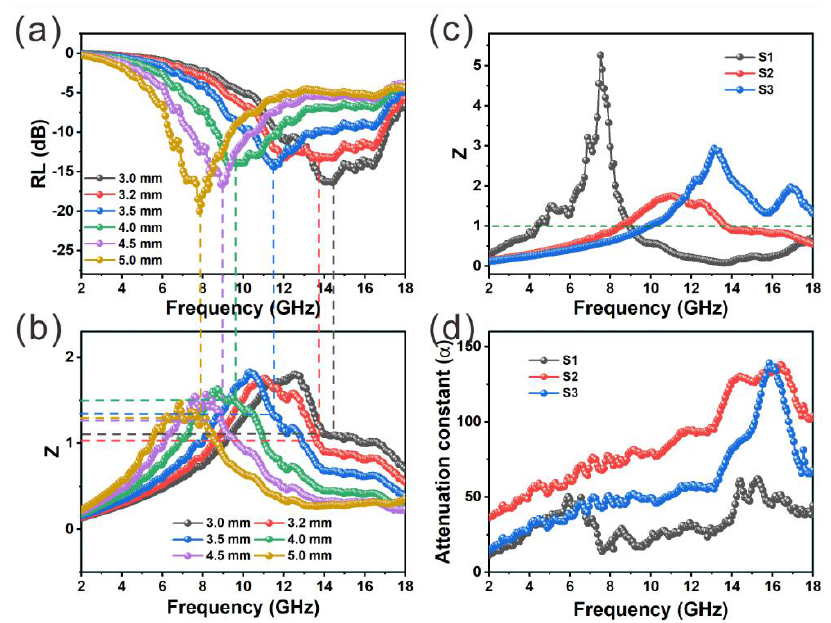
Figure 8. ( a ) RL value and ( b ) impedance-matching characteristics of S2 with various thicknesses; ( c ) the impedance-matching characteristics of S1 − S3 under optimized thickness; ( d ) the attenuation constant ( α ) of S1 − S3.